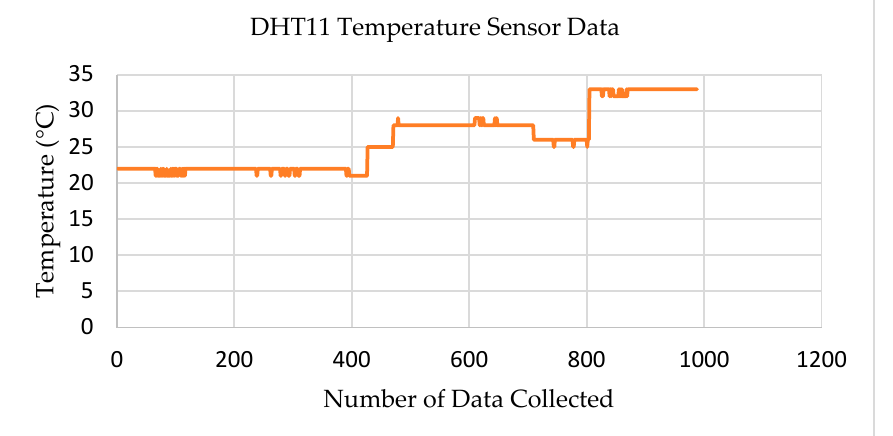
Figure 7. Test results for the MQ-2 gas sensor.